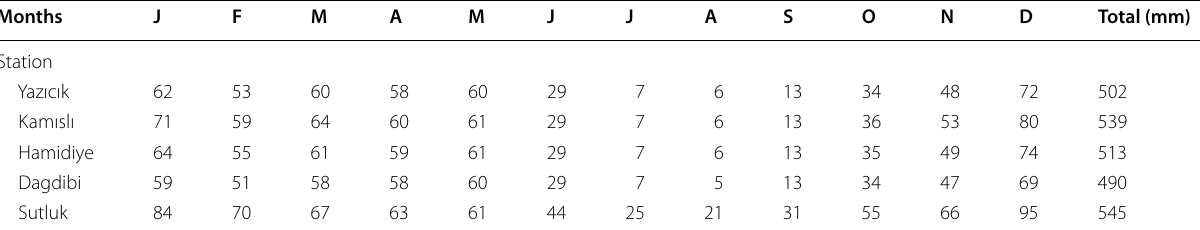
Table 3 Annual average precipitation values of stations in the study area